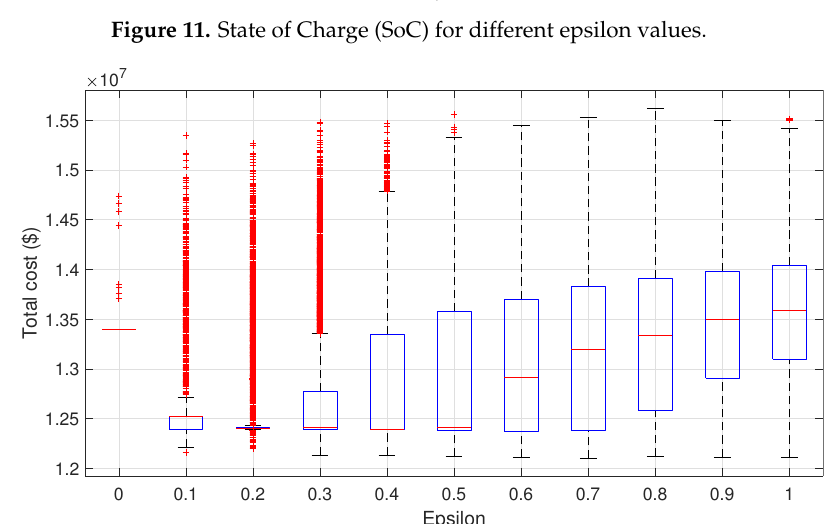
Figure 12. Total cost for different epsilon